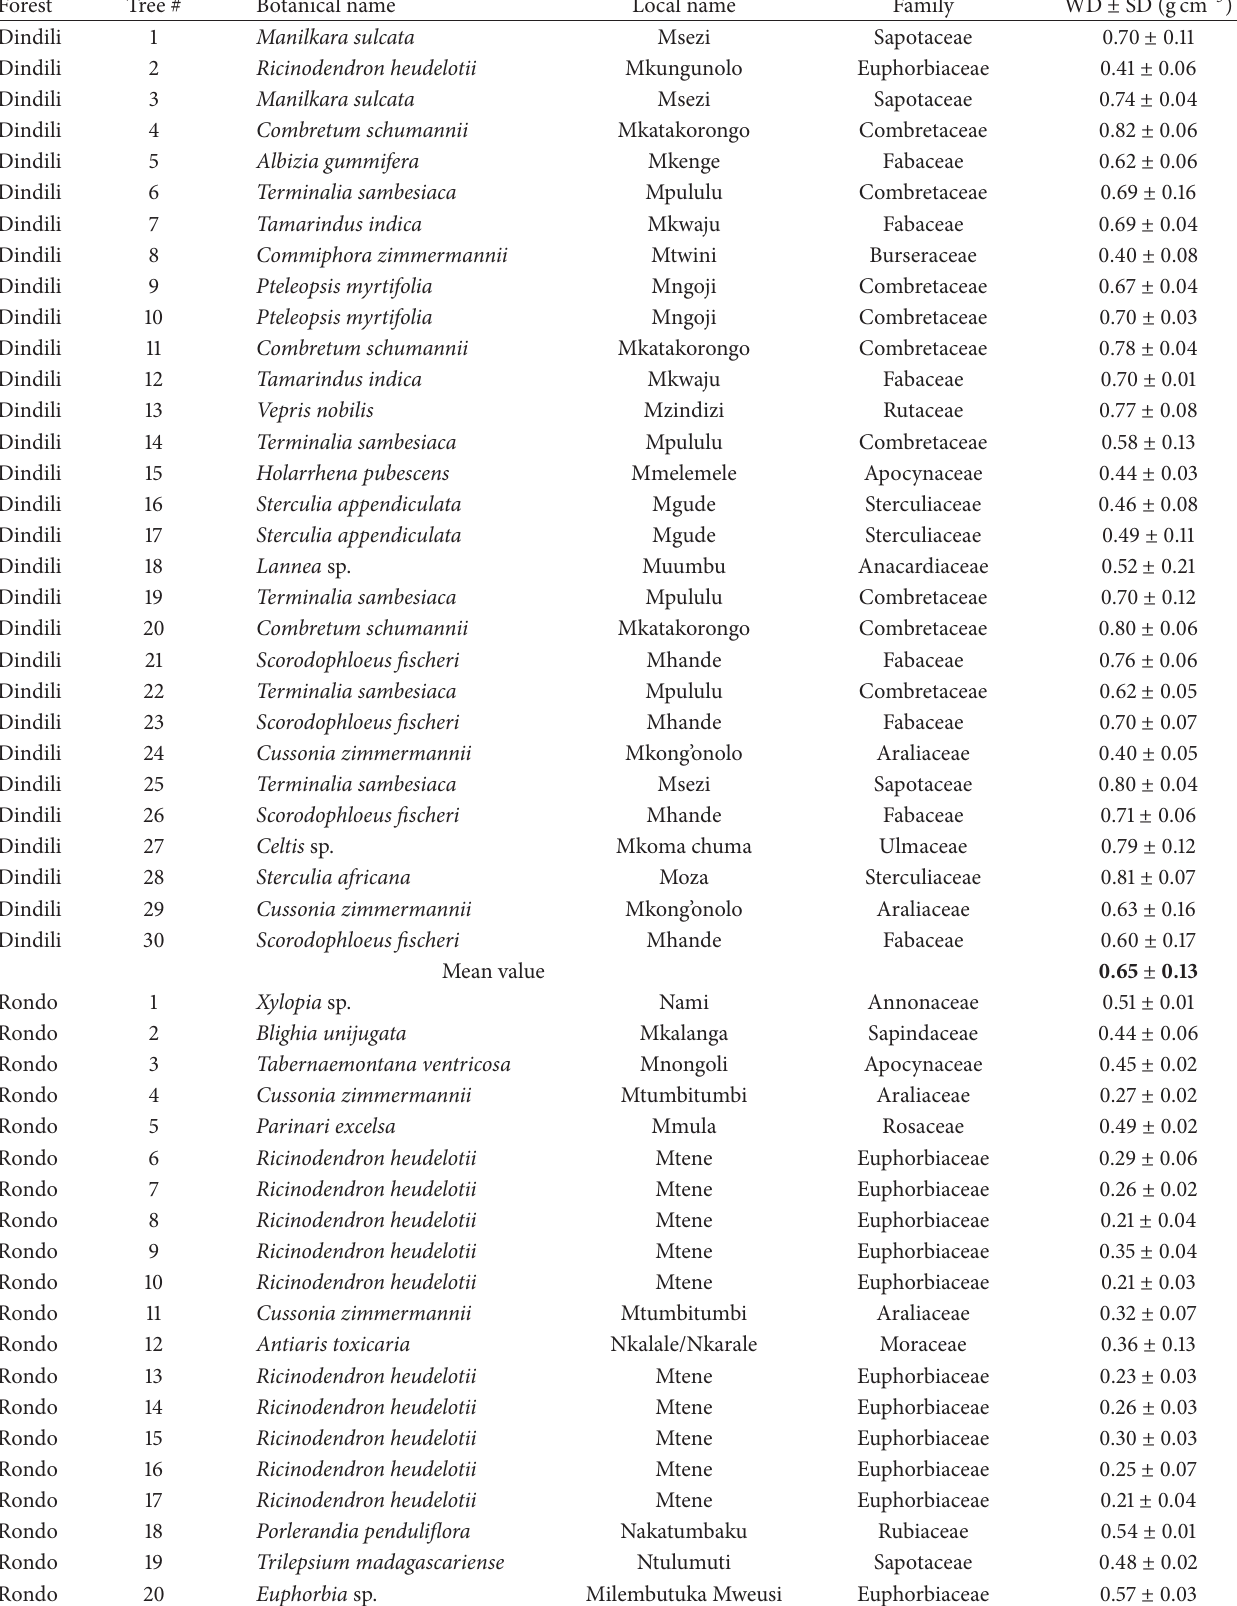
Table 8: Families and wood basic density of sample tree species for allometric model development. Forest Tree